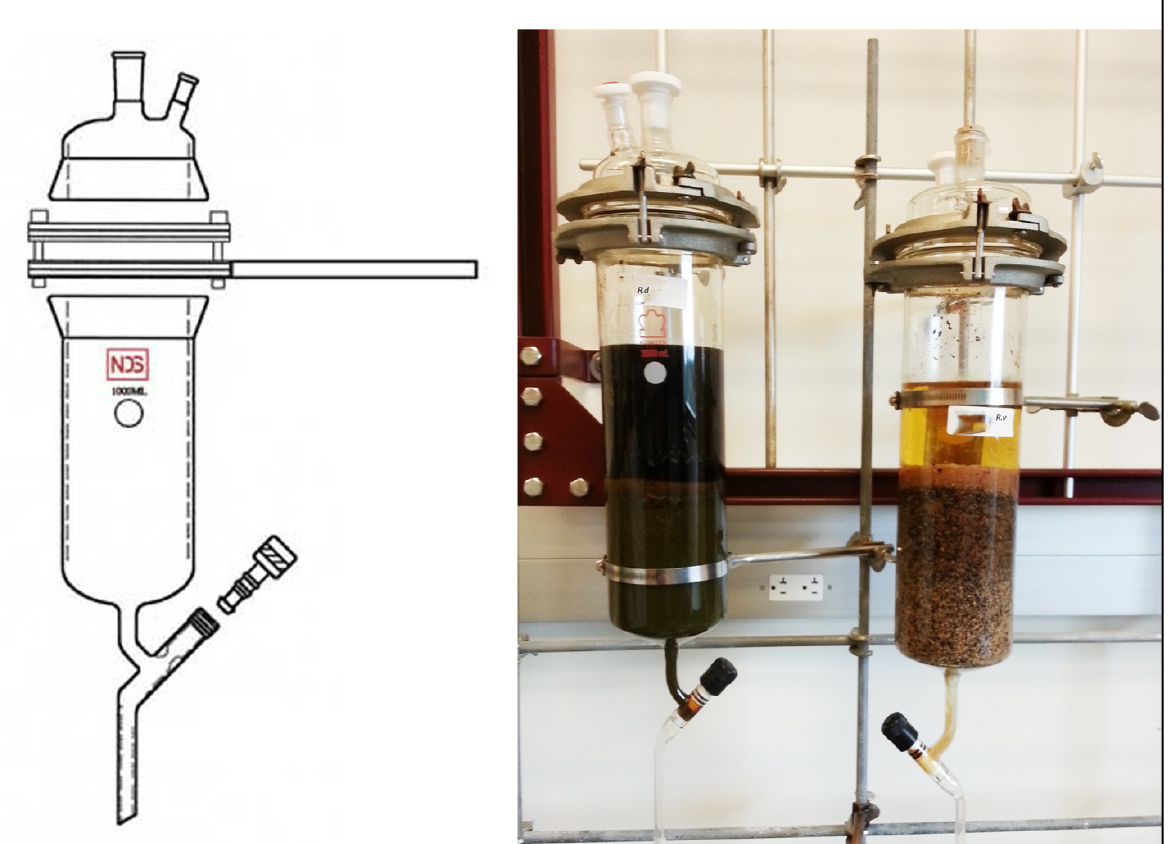
Figure 1. Percolator extractors used for solvent extraction of plant